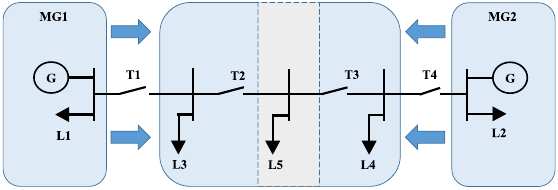
Fig. 1 MG Participation in load